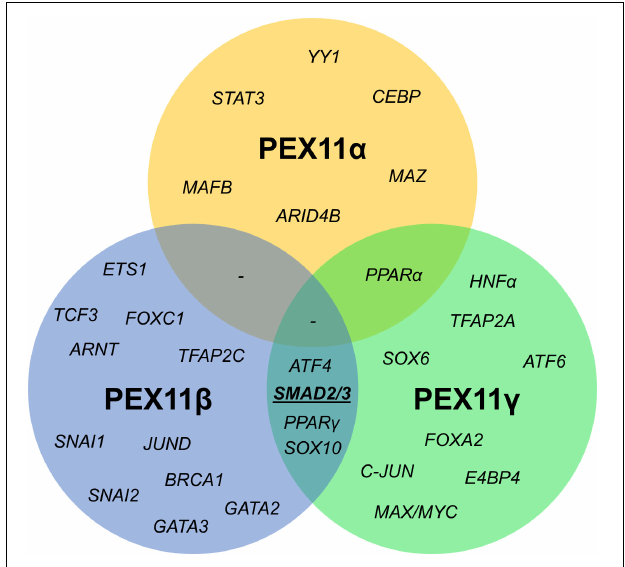
FIGURE 6 | Venn diagram of shared transcription factor binding sites within the promoter regions of human PEX11 isoforms. Potential binding sites for SMAD2/3 (activated by the TGF β pathway) in PEX11 γ and PEX11 β were predicted to be located in a transcriptionally active area according to histone